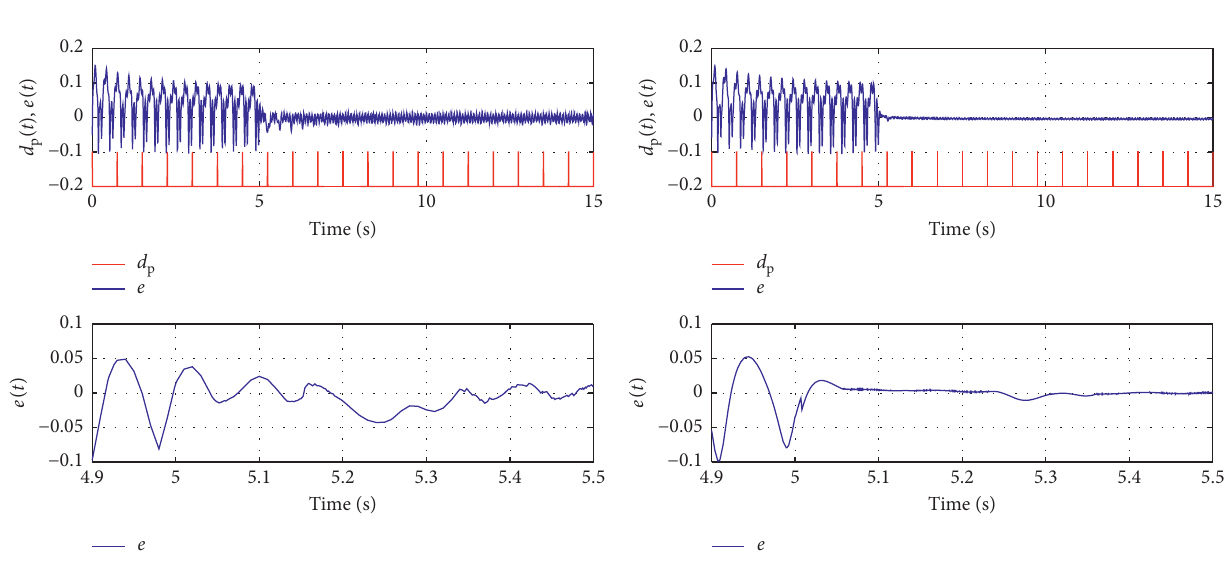
Figure 6: Tracking error of NN-NSM and NN-FFOSM in case